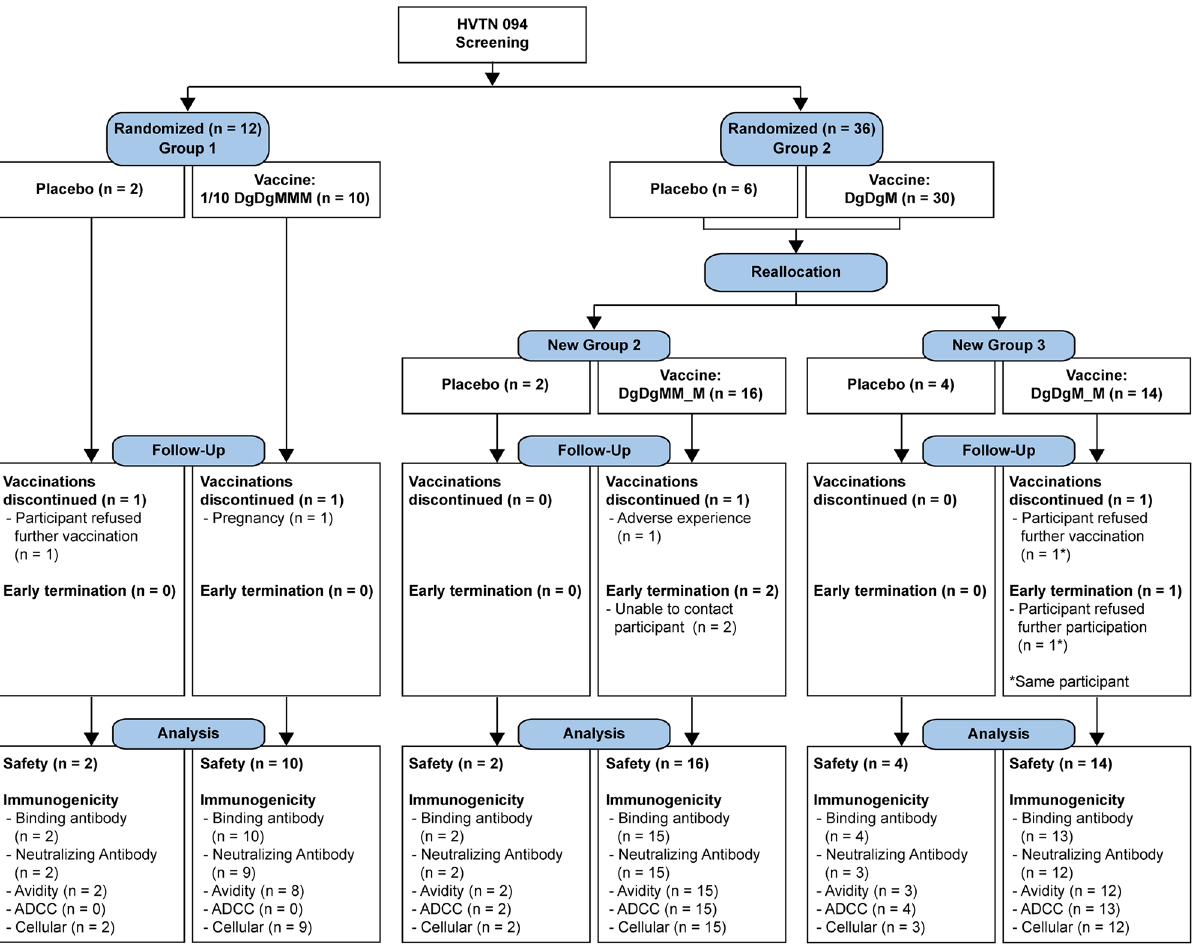
Fig 1. CONSORT flow diagram. Allocation,follow-up, and analysisfor HIV Vaccine Trials Network (HVTN) study 094. Abbreviations: 1/10 DgDgMMM,treatment arm receivingtwo 1/10 doses of DNA followedby three doses of MVA at 0, 2, 4, 6 and 8 months; DgDgMM_M, treatment arm receivingtwo full doses of DNA followedby three doses of MVA given at 0, 2, 4, 6, and 10 months; DgDgM_M, treatment arm receivingtwo full doses of DNA followedby two doses of MVA at 0, 2, 4, and 8 months; ADCC, antibodydependentcellularcytotoxicity.